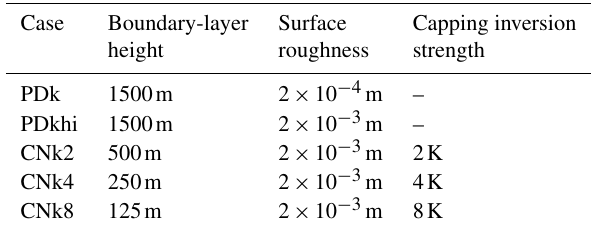
Table 1. Specifications of the TotalControl flow database